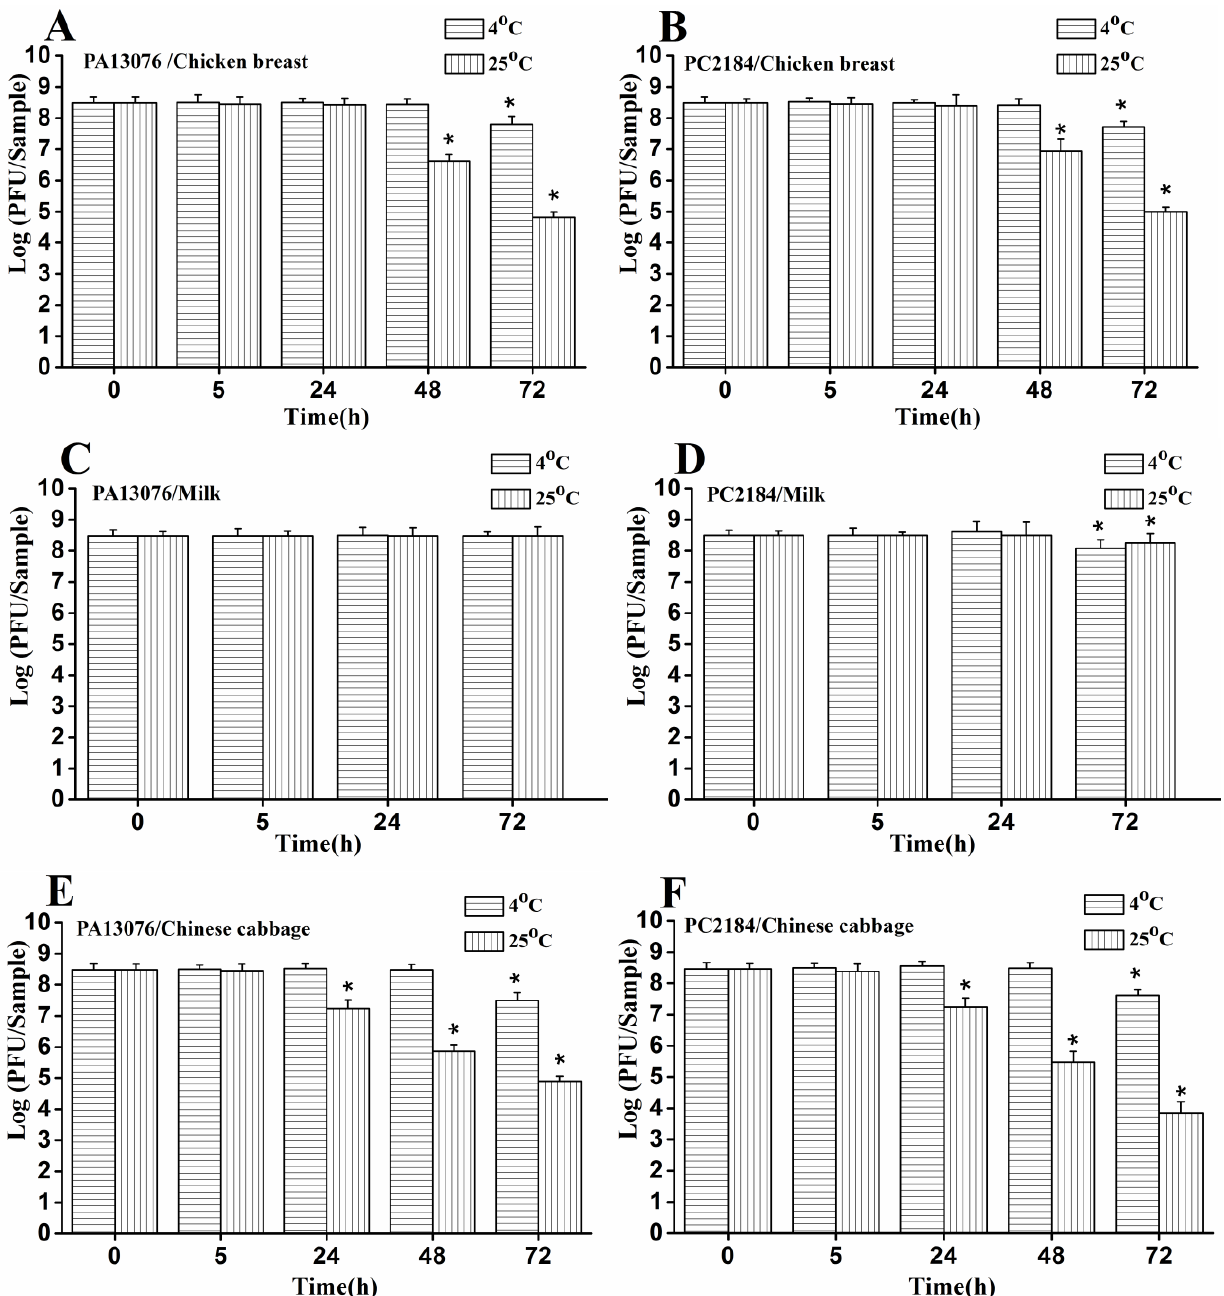
Figure 8. Stability of phage PA13076 and PC2184 over 72 h of incubation on the three kinds of food at 4 °C and 25 °C (the data for the milk sample at 48 h was lacking). Each sample was inoculated with 4 × 10 8 PFU of phage. Date represent the mean ± S.D. ( n = 3), * represents p < 0.05 compared to the original phage numbers (Duncan’s test).